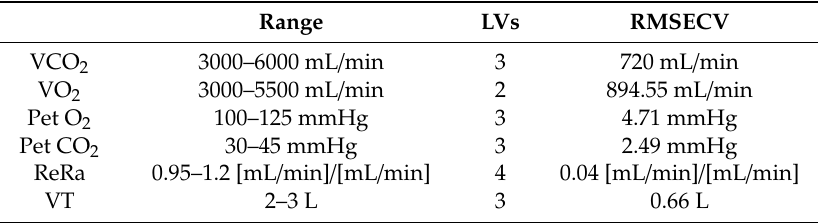
Table 2. Model parameters obtained from exhaled breath analysis.